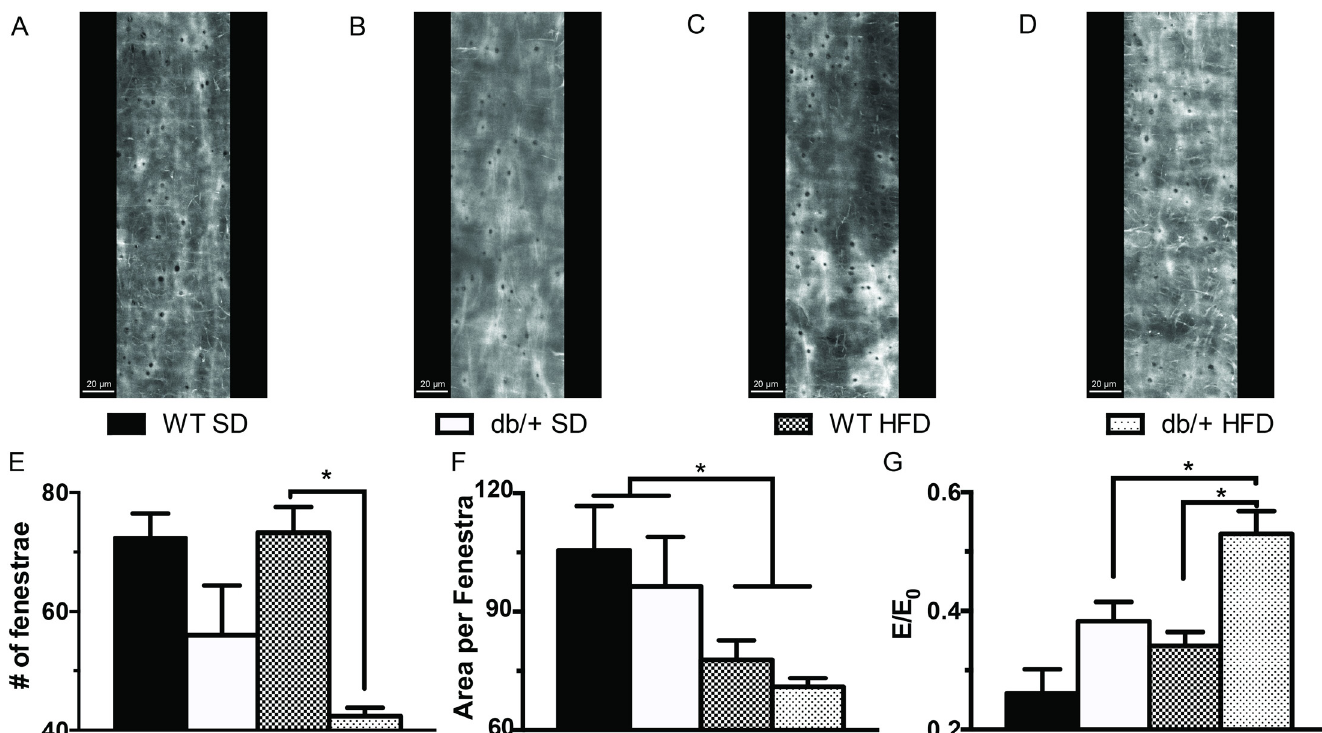
Fig 10. Effect of maternal environment and offspring diet on the internal elastic lamina characteristics of mesenteric resistance arteries from adult (31 week-old) wild type (WT) male offspring of WT-control or Lepr db/+ (db/+) dams. (A-D) Representative confocal images of the internal elastic lamina in mesenteric resistance arteries from each of the treatment group combinations. (E-G) Group data showing the number and area of fenestrae within the internal elastic lamina and the elastic modulus of elasticity normalized as a function of the percolation of the internal elastic lamina and its fenestrae. Data are means ± SEM of n = 4 – 5 number of animals (vessels) per treatment group combination. * P < 0.05. SD, standard diet; HFD, high fat diet.